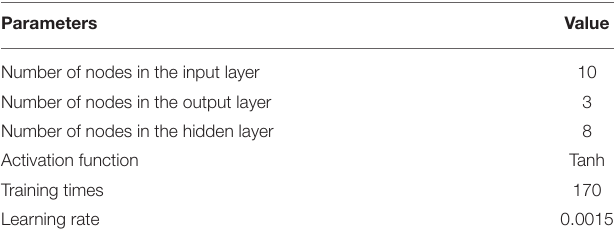
TABLE 6 | Summary of BPNN optimal parameters.